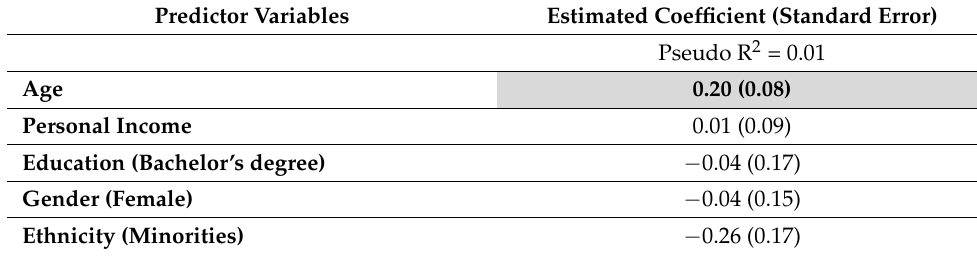
Table 4. The relationship between whether a person was able or unable to access outdoor green spaces because of poor health, and five socio-demographic predictor variables. The Nagelkerke/Crag and Uhler’s pseudo R 2 and estimated parameter coefficients are presented from the GLM, with standard error in brackets. Table cells shaded in grey (with bold numbers) represent significant predictor variables ( p -value ≤ 0.05). The estimated parameter coefficients and confidence intervals for categorical factors are presented relative to a comparative base factor level: Education: no bachelor’s degree; gender: male; ethnicity: majority